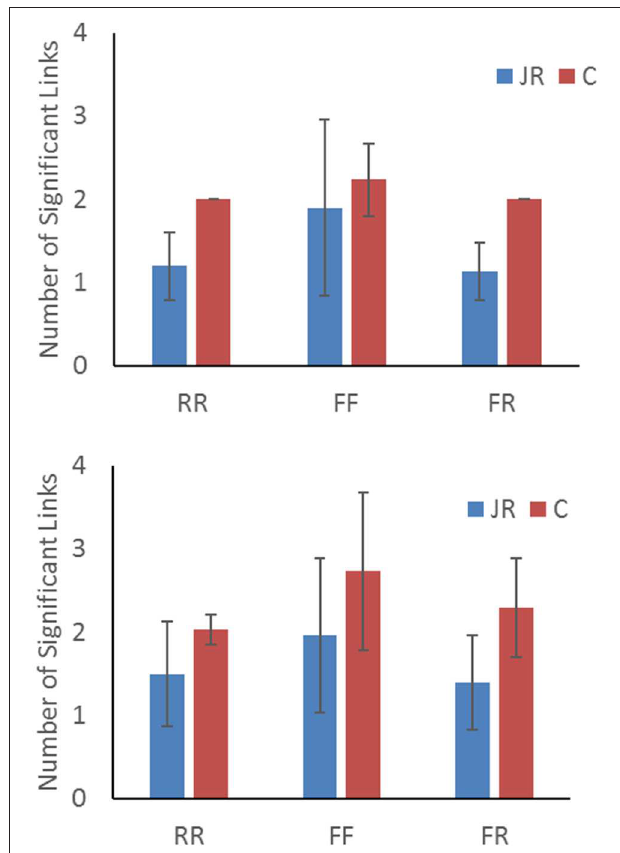
FIGURE 5 | Bar graphs summarizing graph density in terms of number of significant links averaged over all values the TDS similarity threshold parameter( 1 τ ) for both %TDS ( Top ) and TDSLMAX ( Bottom ). Error bars 0 represent ± 1 standard